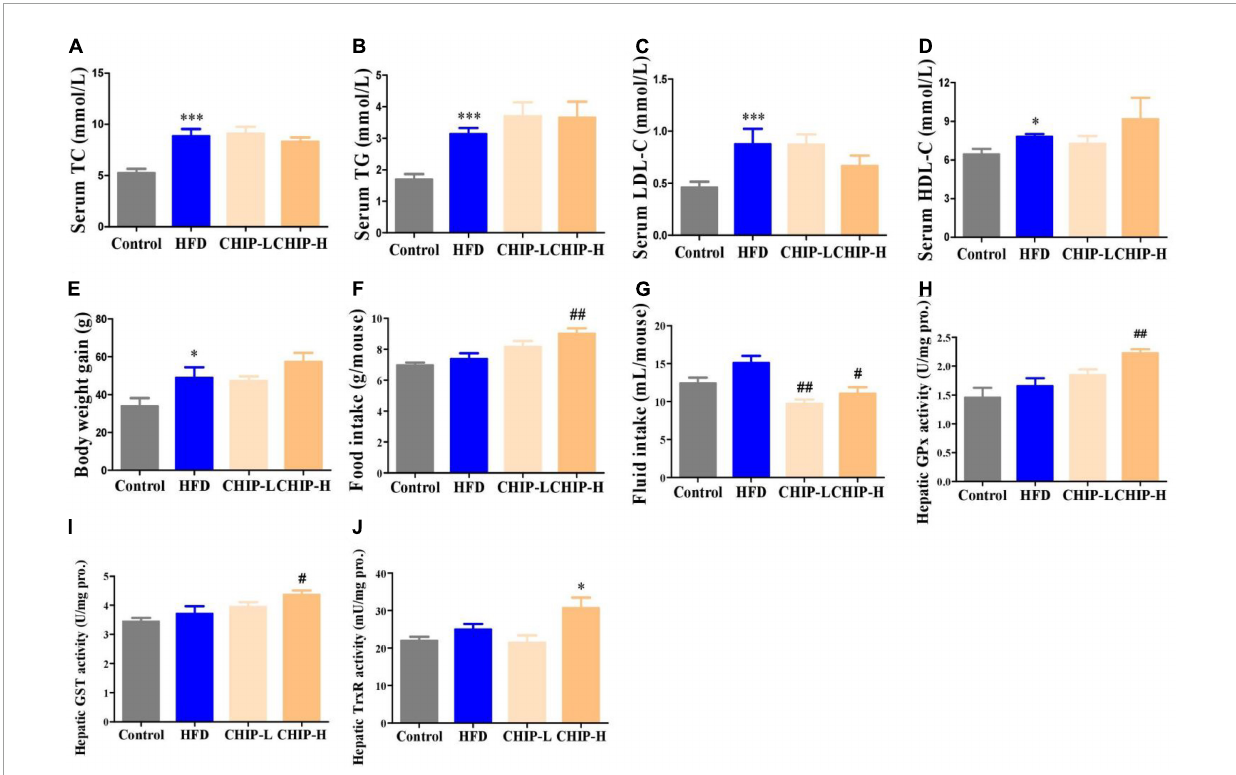
FIGURE4 Effects of CHIP (2% or 6% in diet, m/m) on hyperlipidemia in golden hamsters fed a high-fat diet. Treatments were introduced in animal experiment 4. (A–D) Levels of TC, TG, LDL-C and HDL-C in serum. (E–G) Body weight gain and food and fluid intakes. (H–J) Enzyme activity levels of GPx, GST and TrxR in liver. ∗ p < 0.05, ∗∗∗ p < 0.001, compared to control. # p < 0.05, ## p < 0.01, compared to ALX. NS, p > 0.05. Data are presented as mean ± SEM ( n = 4–8).